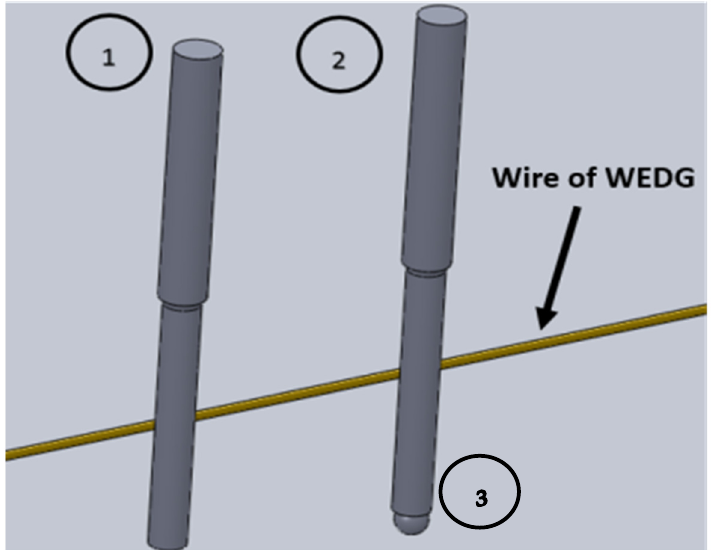
Figure 2. Three steps of microtool dressing: (1) roughing with 0.5 A to 400 μ m, (2) finishing with 50 mA to 350 μ m, and (3) finished spherical tooltip formation.